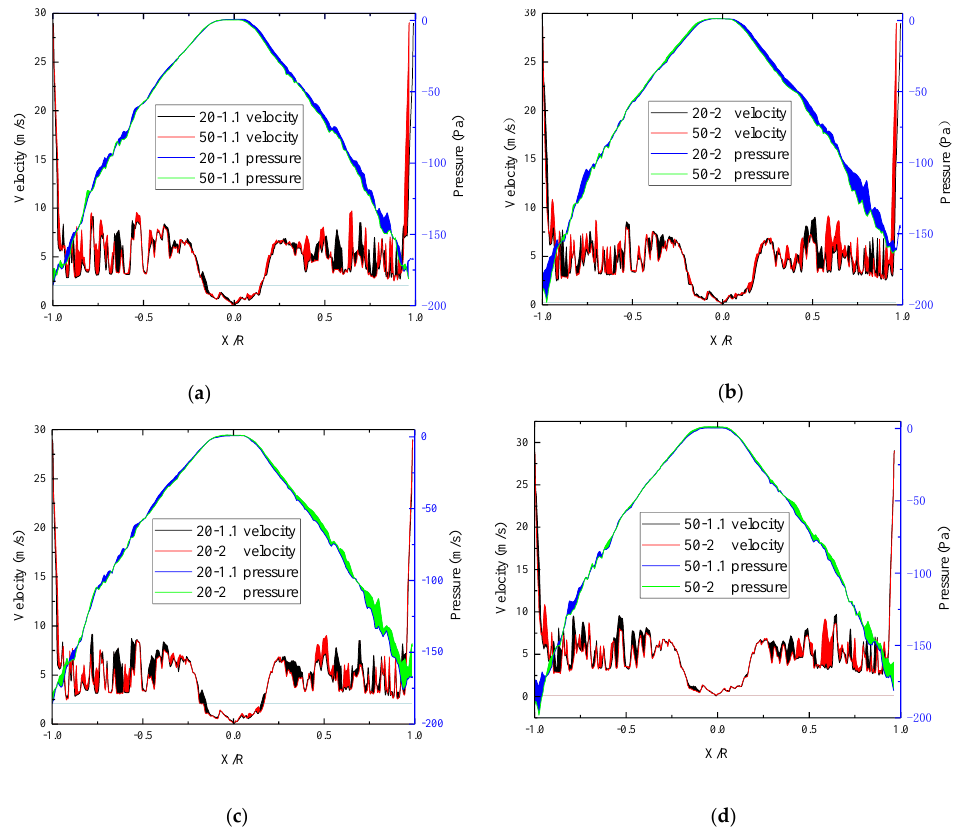
Figure 13. Pressure and velocity distribution of the upper surface of rotor 4 with different configurations: ( a ) 20-1.1 and 50-1.1; ( b ) 20-2 and 50-2; ( c ) 20-1.1 and 20-2; ( d ) 50-1.1 and 50-2.